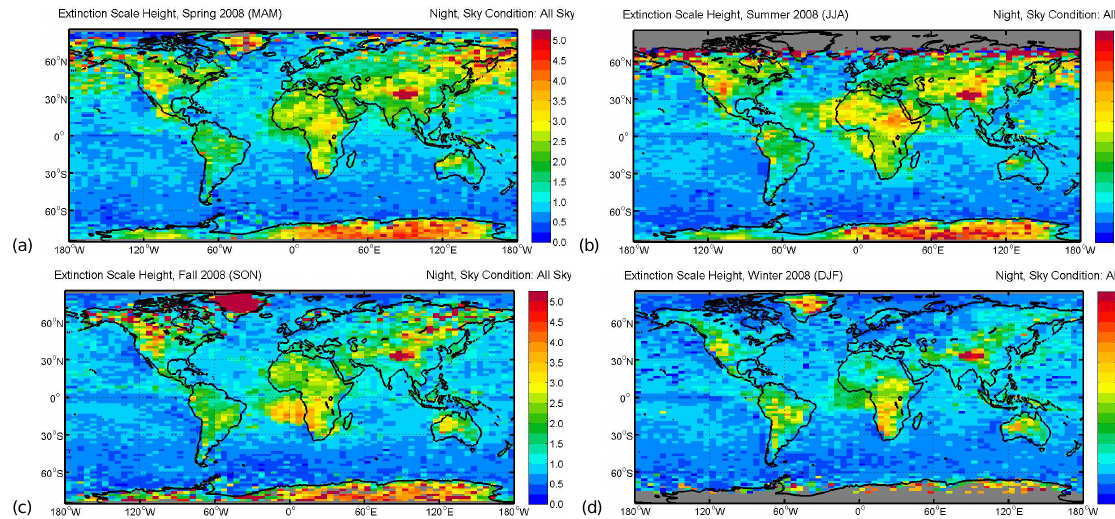
Fig. 9. Seasonal mean H 63 height metric (km) for 2008, nighttime, all-sky: (a) MAM; (b) JJA; (c) SON; (d) DJF.